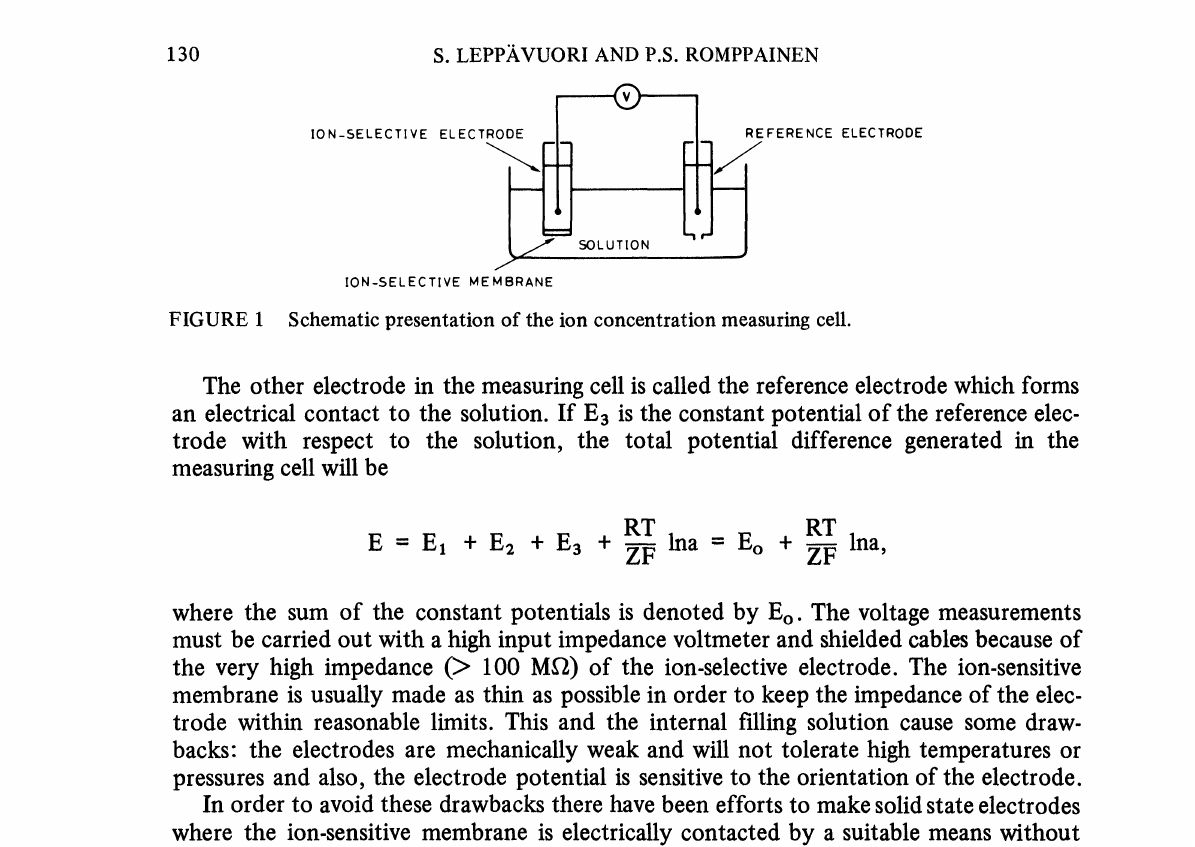
ION-SELECTIVE ELECTRODE FERENCE ELECTRODE